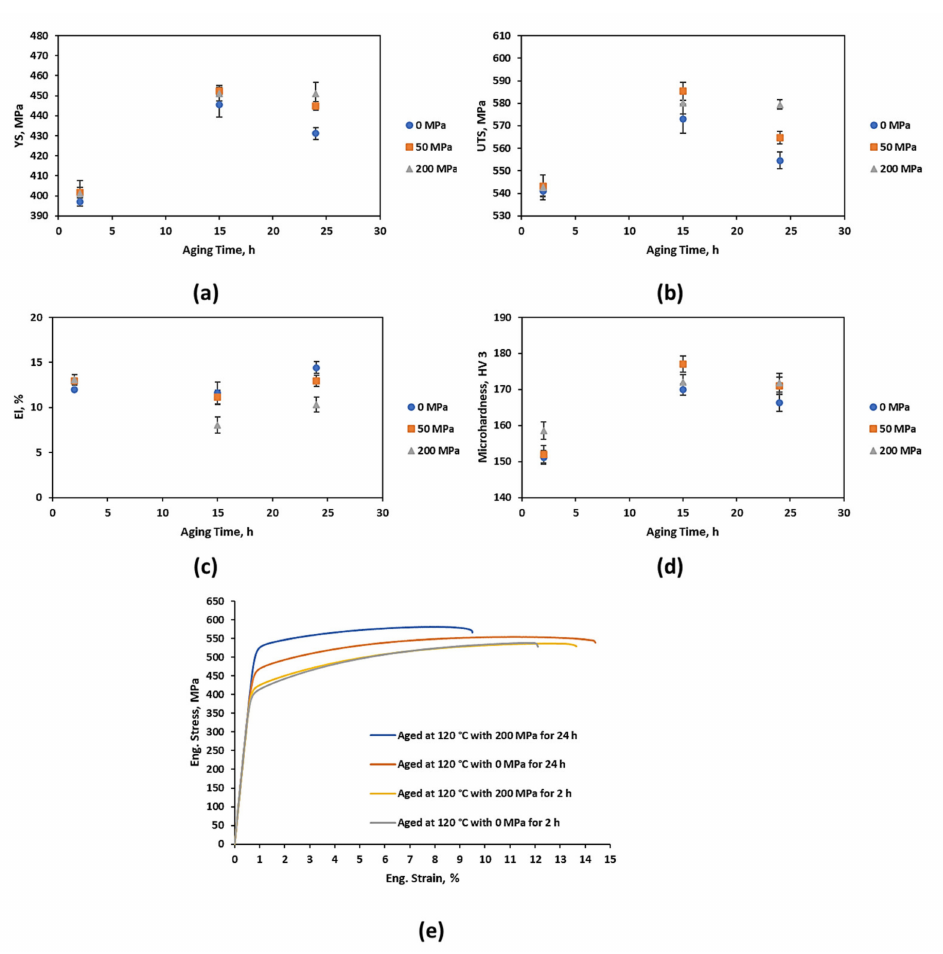
Figure 5. Mechanical properties of EN AW 7075 alloy aged at 120 ◦ C with and without superimposed stress for various times: ( a ) yield strength, ( b ) ultimate tensile strength, ( c ) elongation at failure, ( d ) hardness; in ( e ) selected stress-strain curves are